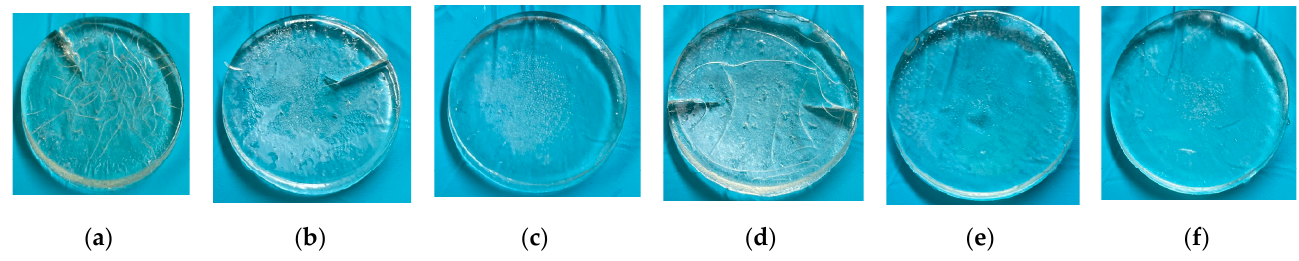
Figure 7. Poor surface quality of FC14 after 72 h of swelling at room temperature.